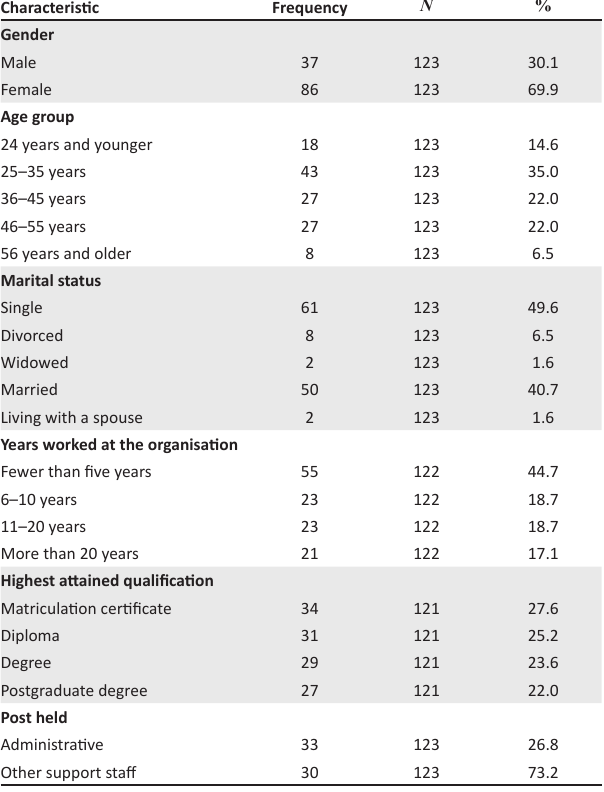
TABLE 1: Characteristics of the